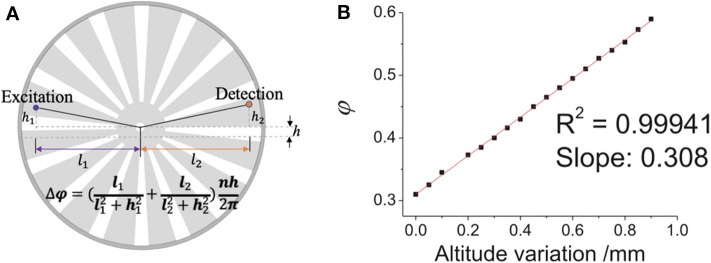
Diagram of the change of the chopper altitude. (A) Schematic diagram of adjusting the phase difference between pulse excitation (left spot) and shutter (right spot). (B) The phase difference (ϕ) vs. the altitude variation of the chopper wheel (the delay time Δt = T∙φ). Reprinted from Zhu and Shu (2019). Copyright (2019), with permission from Elsevier.